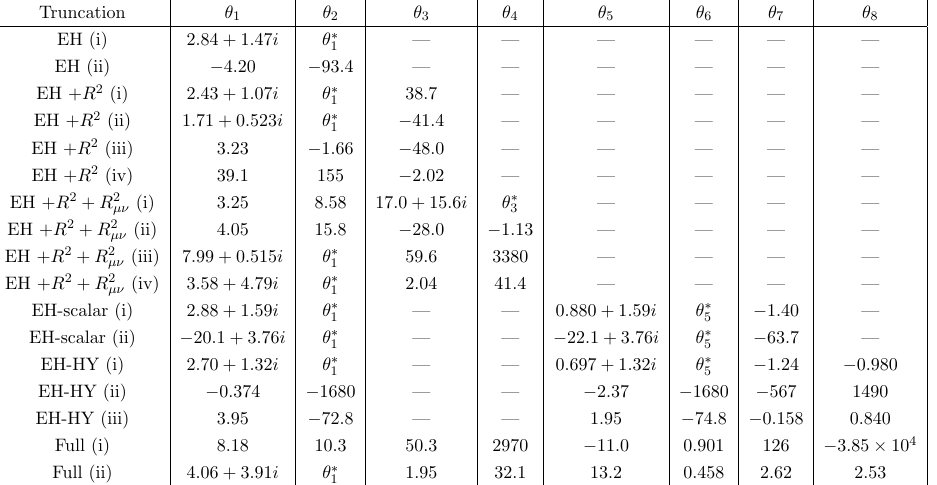
Table 6 . The values of critical exponents for (cid:11) = 0 and (cid:12) = (cid:0) 1.